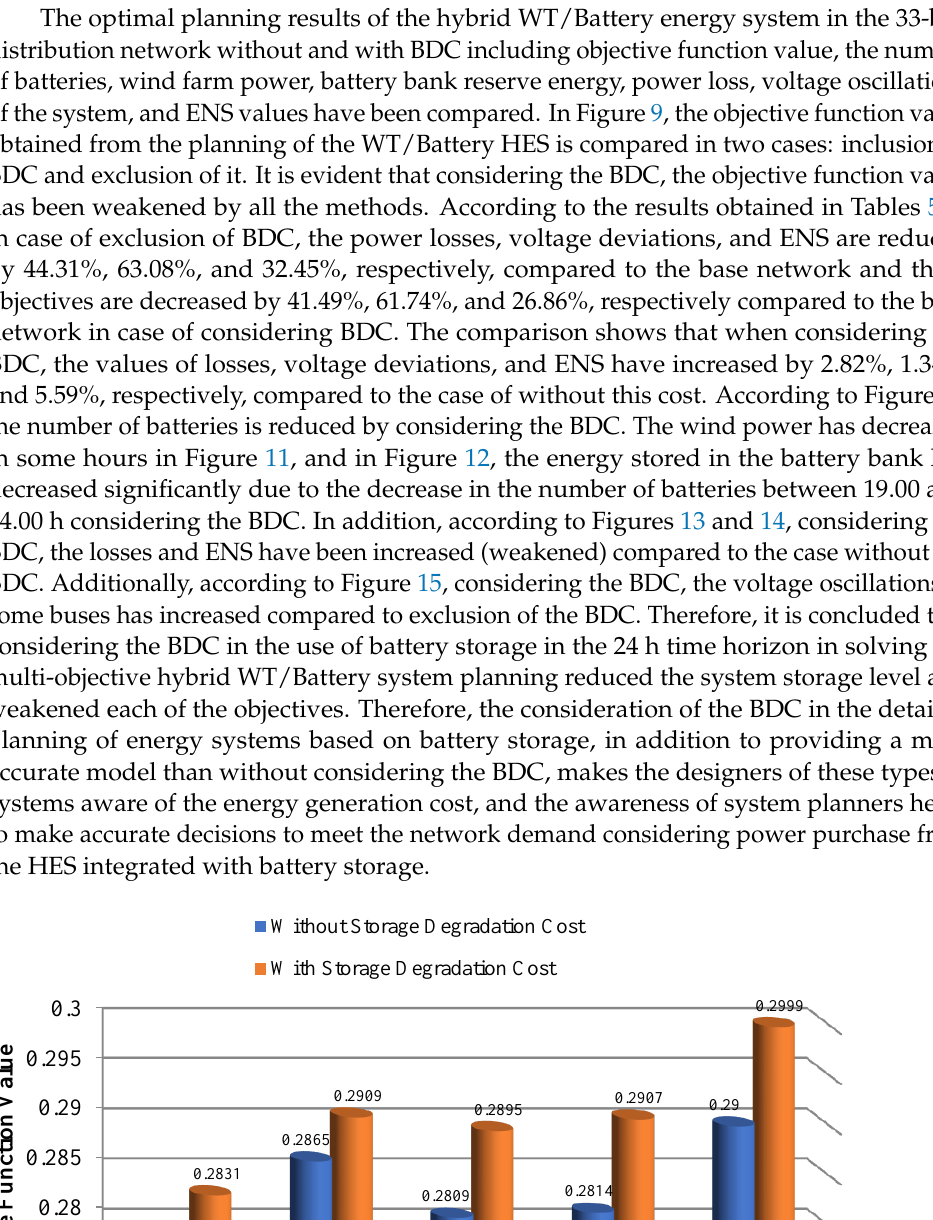
Figure 10. Number of batteries without and with BDC in WT/Battery scheduling using the IFLA.